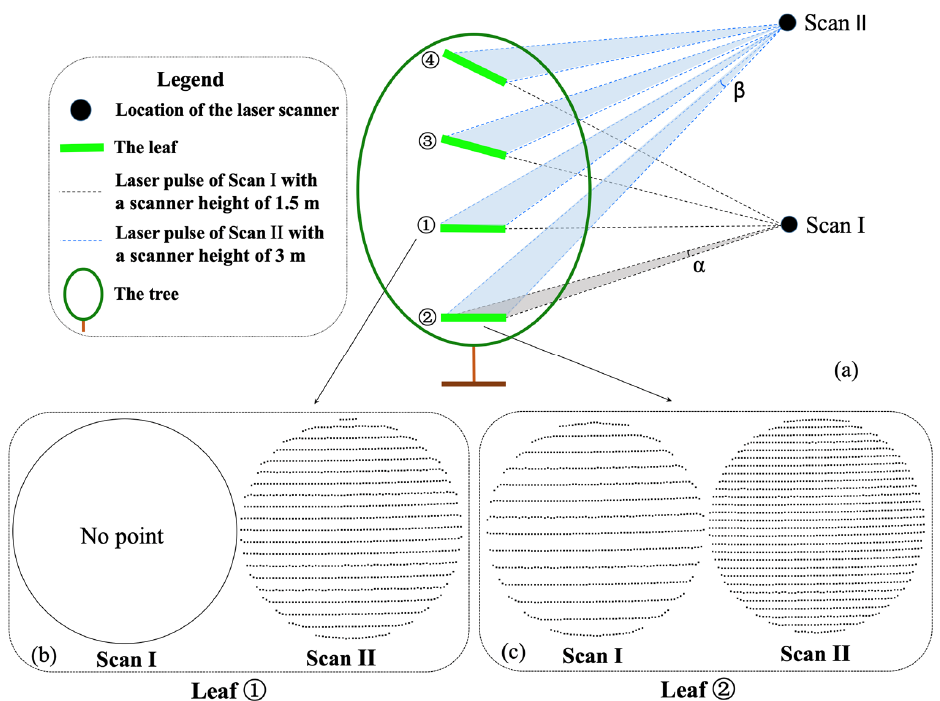
Figure 9. The occlusion effect in terrestrial laser scanning (TLS) and the effect of the scanner height (SH) ( a ) on the scanned points ( b , c ). Leaf ① and leaf ② are horizontal, leaf ③ and leaf ④ are slanted. The leaves are represented by a straight line because they are illustrated from the side. Dashed lines represent pulses emitted by TLS: the black and blue dashed lines are the pulses emitted by Scan I and Scan II, respectively. α and β are the angles between the emitted pulses of Scan I and leaf ② and between Scan II and leaf ② , respectively, β > α.